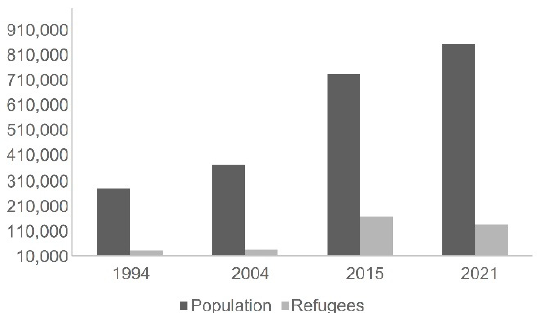
Figure 2. Population and refugees’ dynamics in Irbid district (1994–2021).